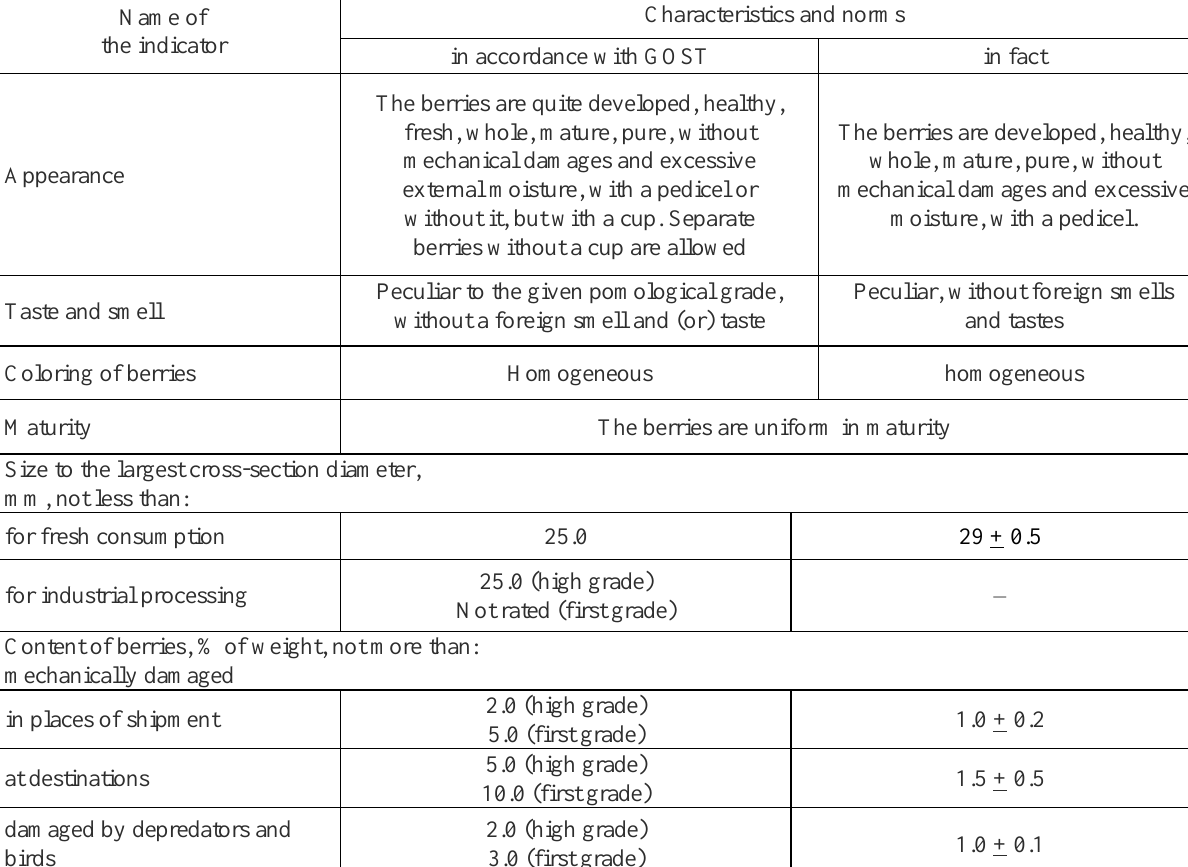
Table 7. Indicators of quality of Fragaria (remontant wild strawberry , the grade “Berdskaya rannyaya”), n = 5 Name